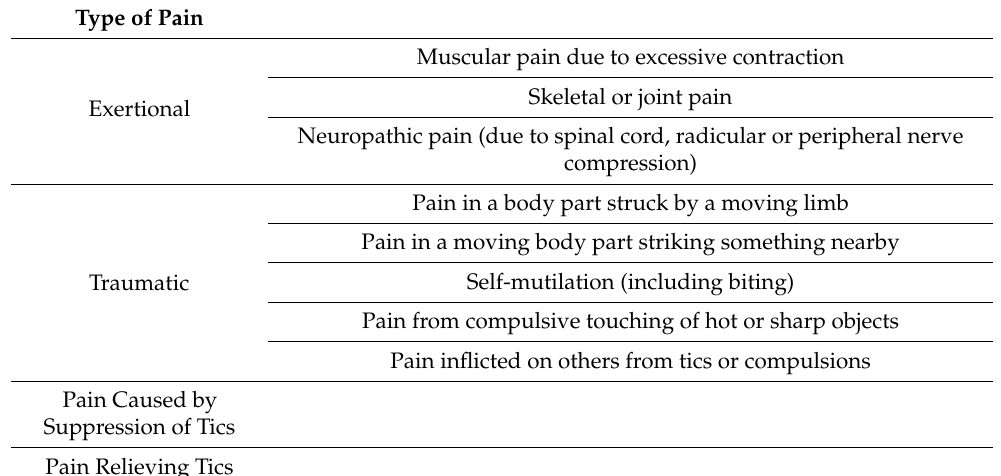
Table 1. Classification of Pain in Relation to Tic